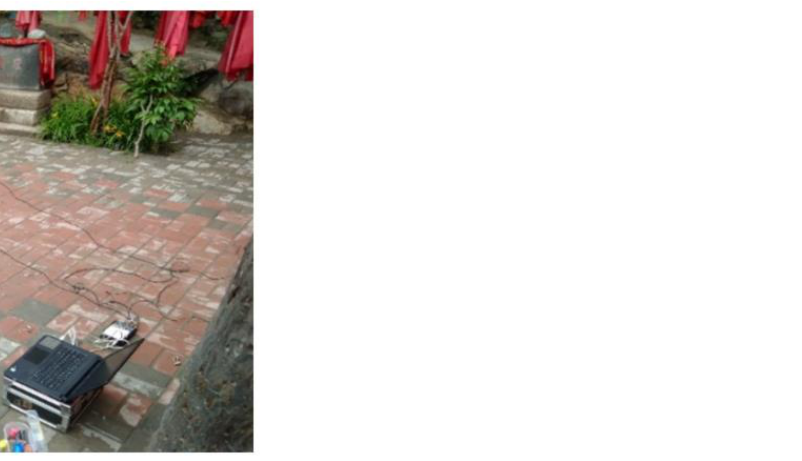
Figure 3. Positions of the tunnel and temple.